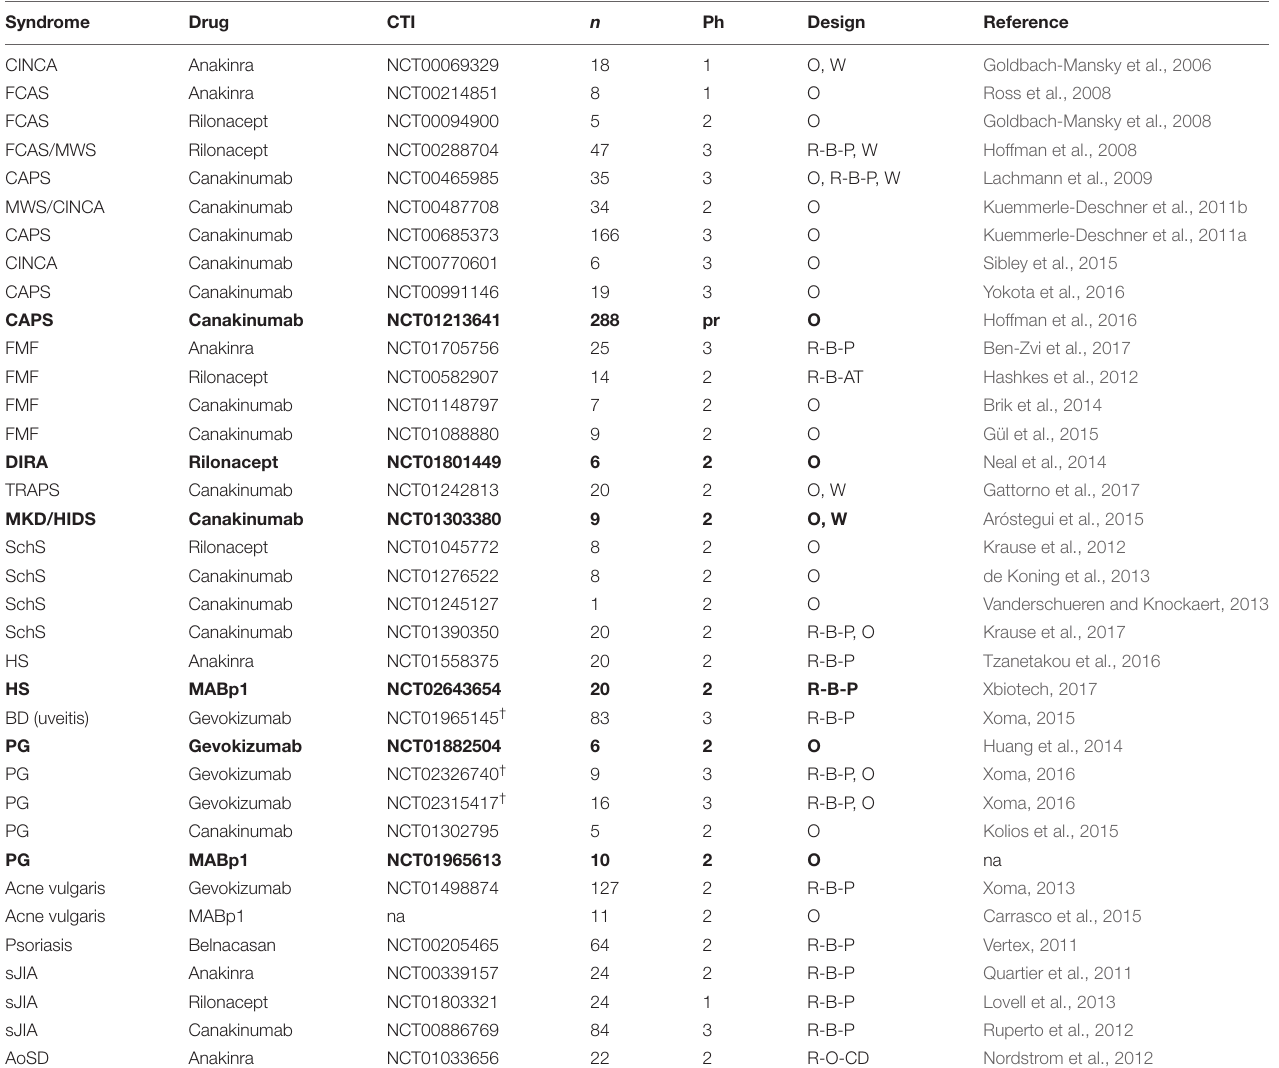
TABLE 2 | Selected clinical trials targeting IL-1 in inflammatory skin